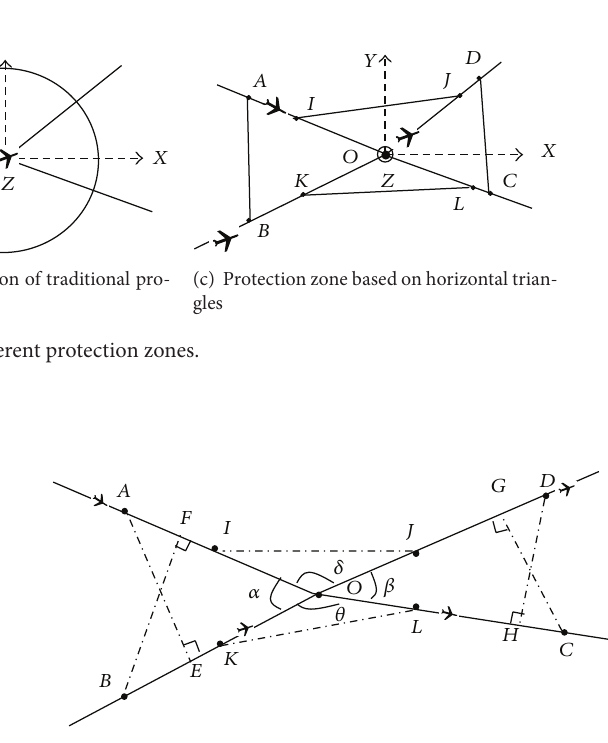
Figure 2: Possible types of conflicts.